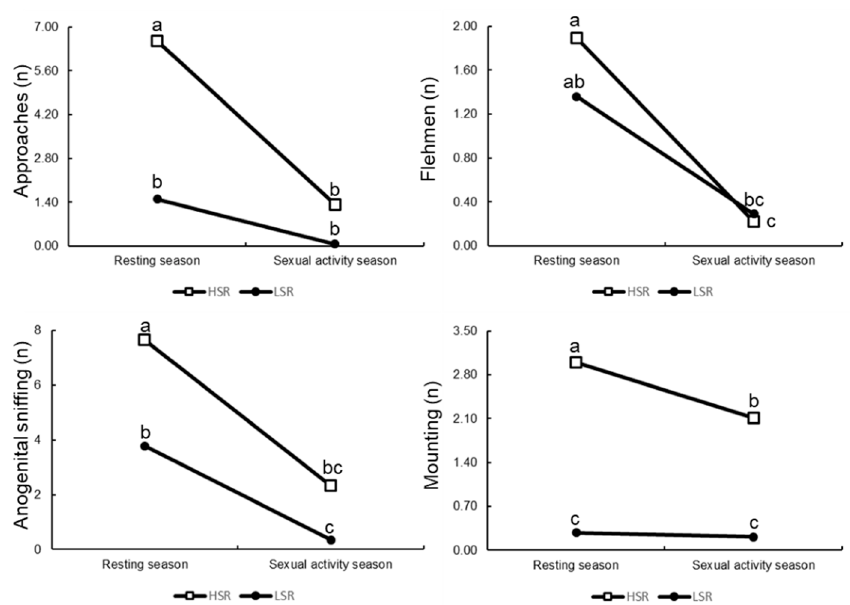
Figure 3. Least squares means for the appetitive and consummatory sexual behaviors, considering approaches, flehmen, anogenital sniffing, and mounting, according to either low ( n = 15) or high ( n = 9) social rank in Dorper rams in northern Mexico (25 ◦ N), during resting and sexual activity season. a,b,c Least squares means lacking a mutual superscript within response variable differ ( p < 0.05). Table 4. Least square means ± standard error for the sexual male-to-female actions consider- ing rejection to mate, approaches, flehmen, anogenital sniffing, and mounting, according to time (T; i.e., reproductive arrest—July or early reproductive season—Sept) and either low ( n = 15) or high ( n = 9) social rank in Dorper rams ( n = 24) in northern Mexico (25 ◦ N) 1,2 .